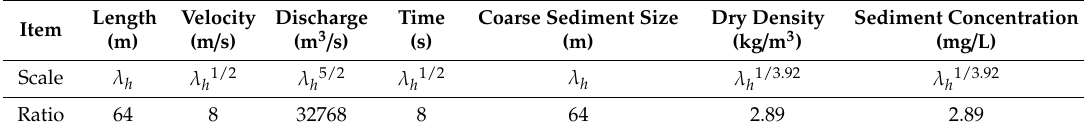
Table 1. Scale ratio of the flow patterns and sediment